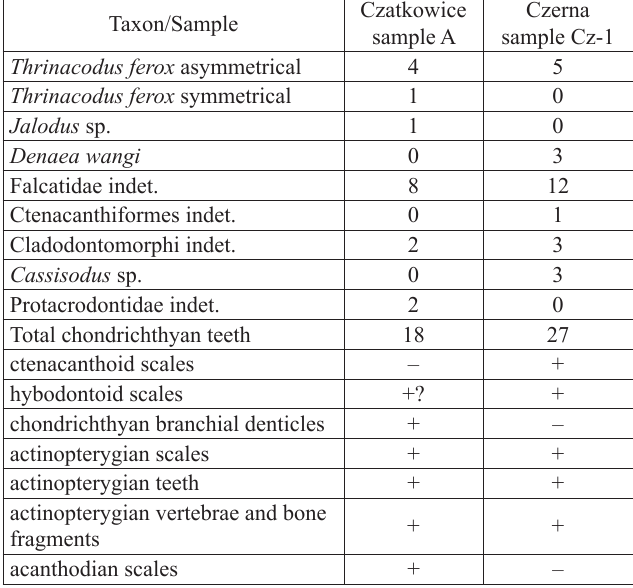
Table 1. Vertebrate microremains in the samples from the upper Tour- naisian of Czatkowice Quarry and the upper Viséan of Czerna.